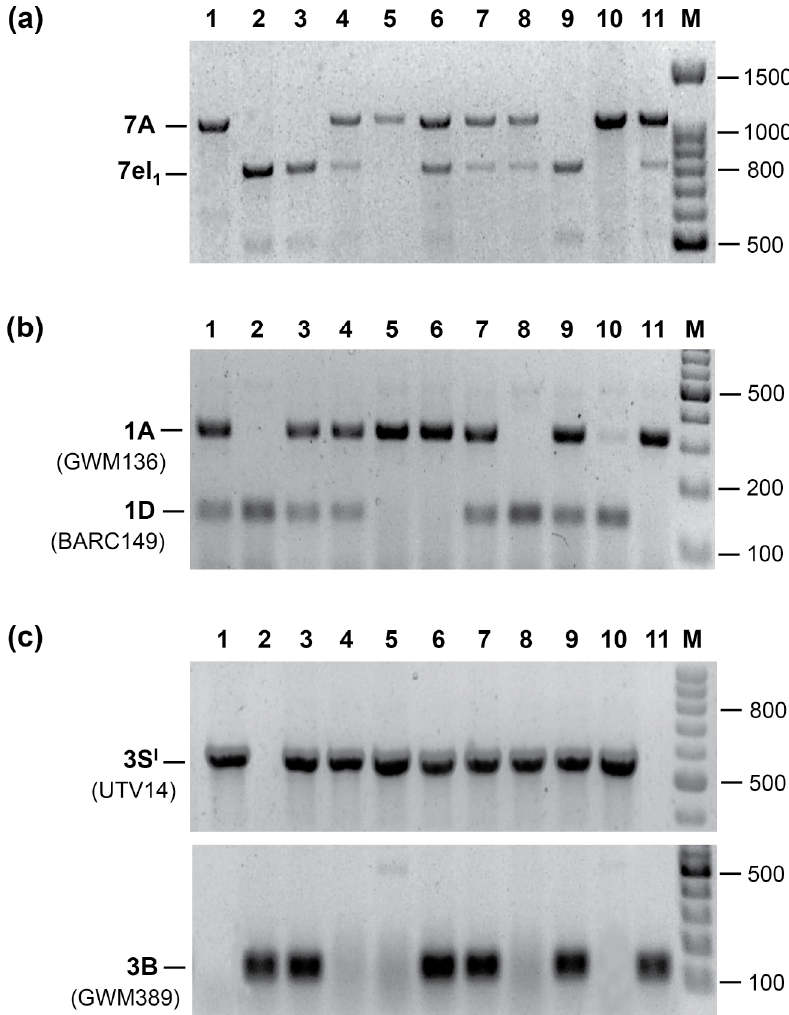
Figure 2. Profiles of PCR-based markers used to select multiple recombinant genotypes in durum wheat segregating progenies. ( a ) Multiplex PCR with STS (sequence tagged site) primer combination [33] generates a codominant assay for the presence of Lr19 and associated genes into the same 7el 1 L Th. ponticum segment, including Yp and Sr25 (see text): lanes 2, 3, 9 (7el 1 L homozygous carriers, HOM+); lanes 1, 5, 10 (7el 1 L homozygous non-carriers„ HOM − ); 4, 6, 7, 8, 11 (7AL-7el 1 L heterozygotes, HET); ( b ) Multiplex PCR with primers for SSR (simple sequence repeat) markers associated to the 1AS and 1DS segments, the latter including GliD1/GluD3 genes [25,26]: lanes 2, 8, 10 (1DS HOM+); lanes 5, 6, 11 (1DS HOM − ); lanes 1, 3, 4, 7, 9 (1DS-1AS HET); ( c ) A Pm13 (3S l S)-associated STS marker (UTV14, [34]), combined with a 3BS-linked SSR marker (GWM389): lanes 1, 4, 5, 8, 10 (3S l S HOM+); lanes 2, 11 (3S l S HOM − ); lanes 3, 6, 7, 9 (3S l S-3BS HET). M = 100 bp ladder (relevant base pair figures on the right side of gels).